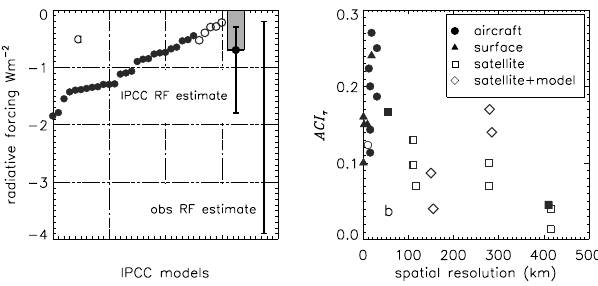
Fig. 1. (a) Radiative forcing estimates by each IPCC model and the overall IPCC radiative forcing estimate in comparison to an ob- servational estimate for the cloud albedo effect resulting from the values in 1b. (b) Values from the literature quantifying the albedo effect using some variant of Eq. (1), expressed here as ACI τ , and plotted as a function of scale (resolution) of the study. Closed sym- bols are those that calculate the original variant of ACI with con- straint on cloud water and open symbols are those that ignore the constraint on cloud